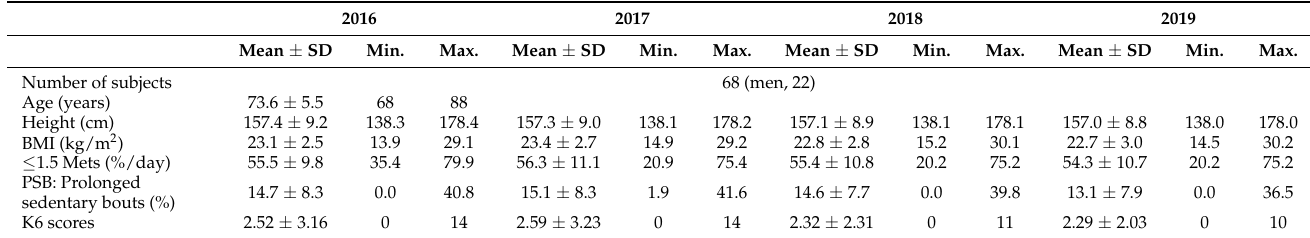
Table 1. Clinical characteristics of enrolled subjects.